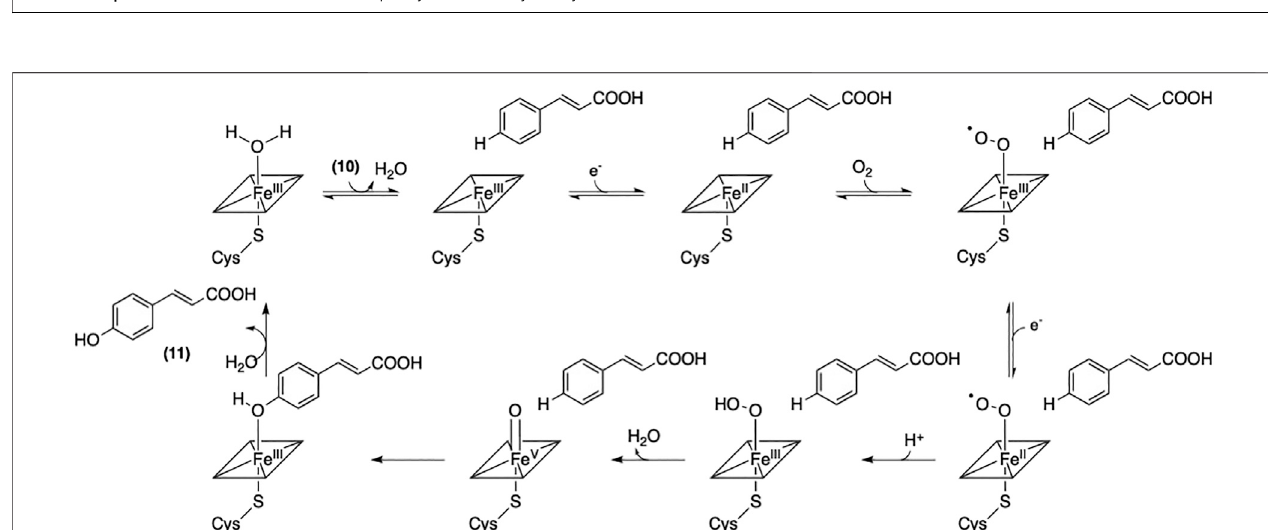
FIGURE 6 | Mechanism of the formation of p -coumaric acid catalyzed by C4H.